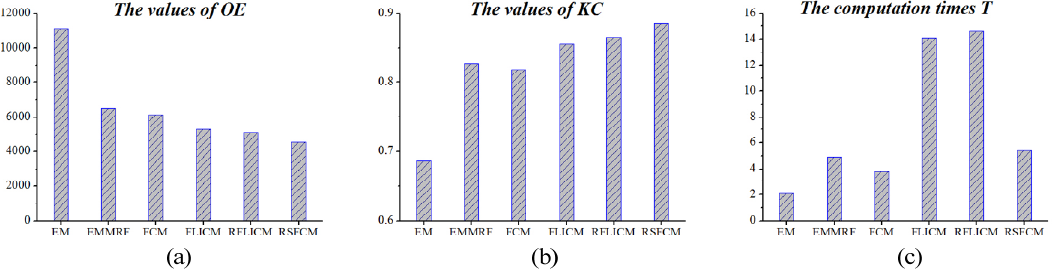
Figure 15. Average results from different datasets ( a ) OE values; ( b ) KC values; and ( c ) computation times T.